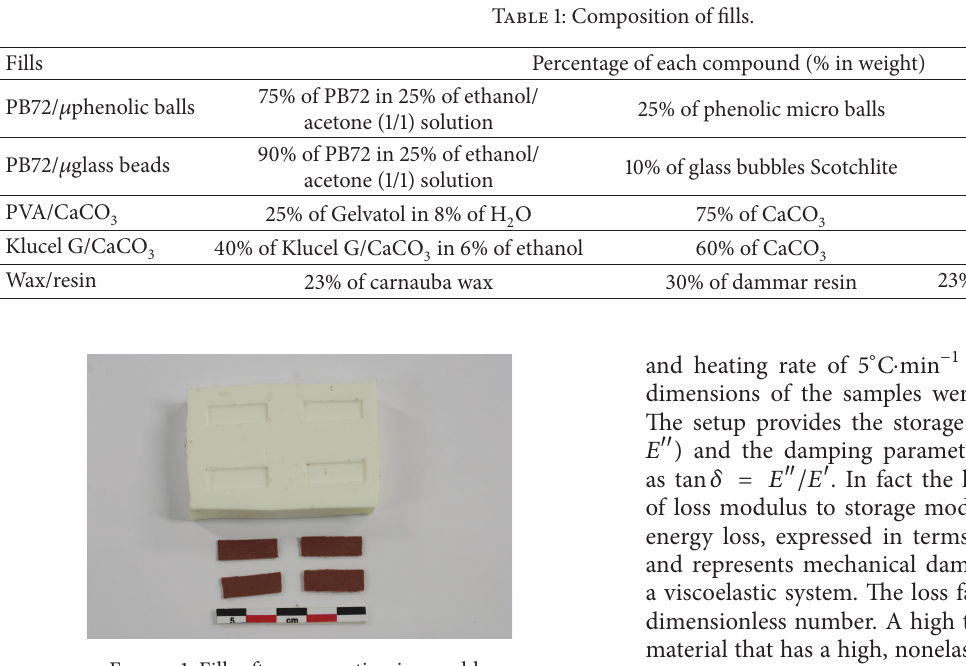
Figure 1: Fills after preparation in